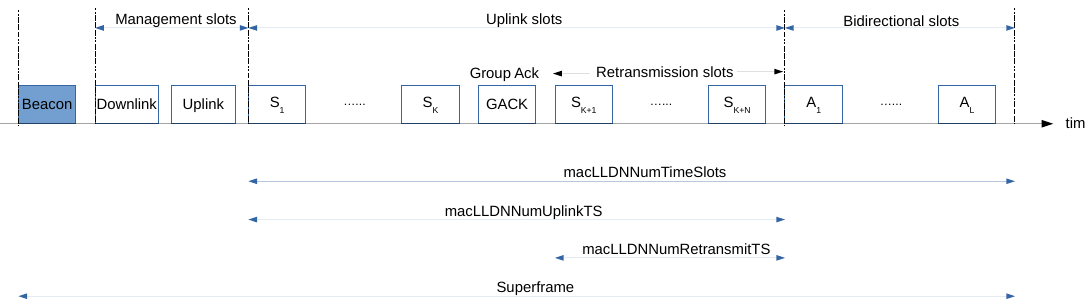
Figure 1. Superframe structure (with separate group acknowledgement), compare ([6] Figure